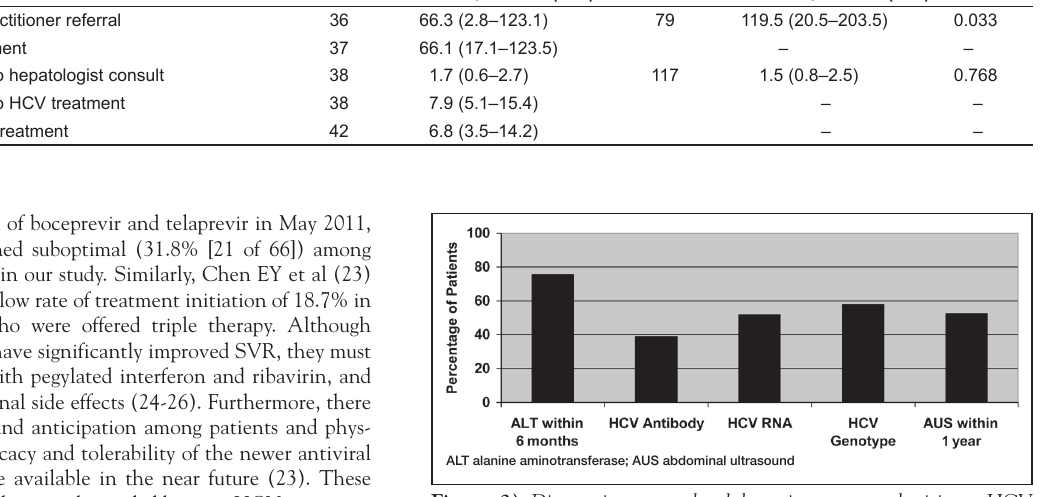
Table 5 Time interval from hepatitis C virus (HCV) diagnosis to treatment initiation Interval,